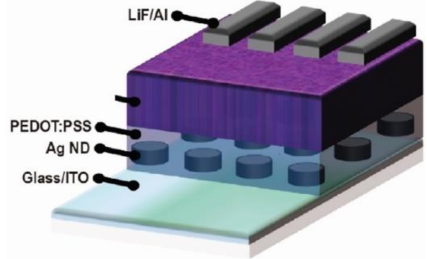
Figure 15. Schematic representation of an OPV device with Ag NDs. Adapted with permission from [291]. Copyright 2016, American Chemical